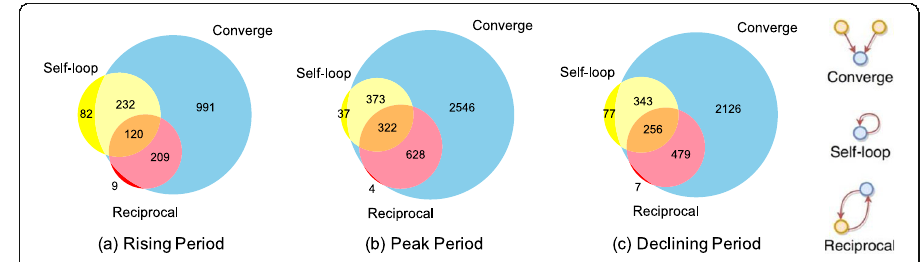
Fig. 8 The overlap and independence of three important structures of communication